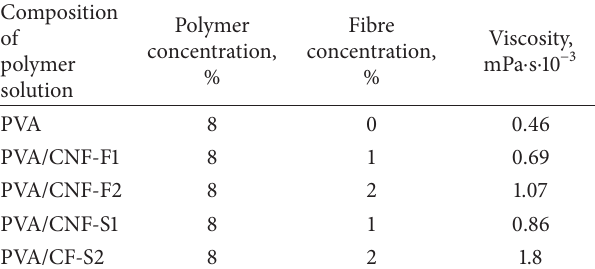
Table 3: Viscosity of the polymer